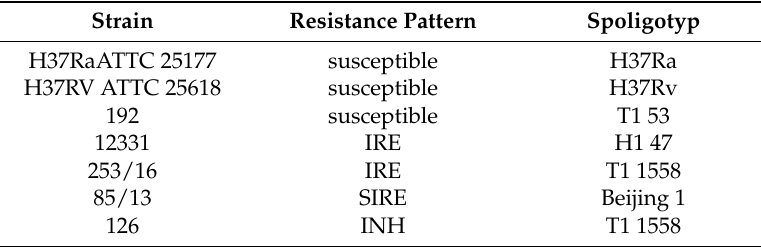
Table 1. Characterization of investigates strains.